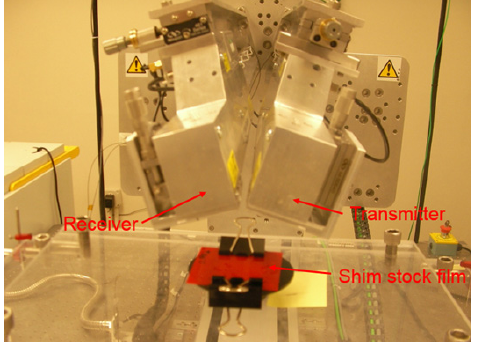
Figure 2. A photo of the THz-TDS system for imaging and measuring material parameters.